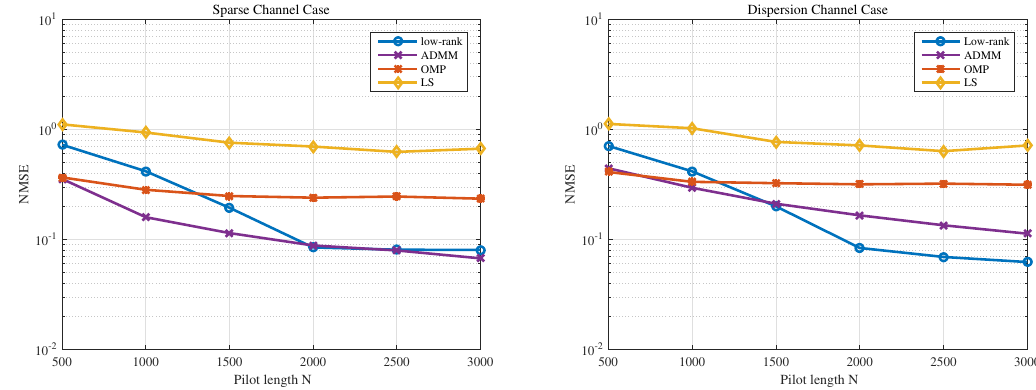
Figure 6. NMSE comparison versus Signal length N .